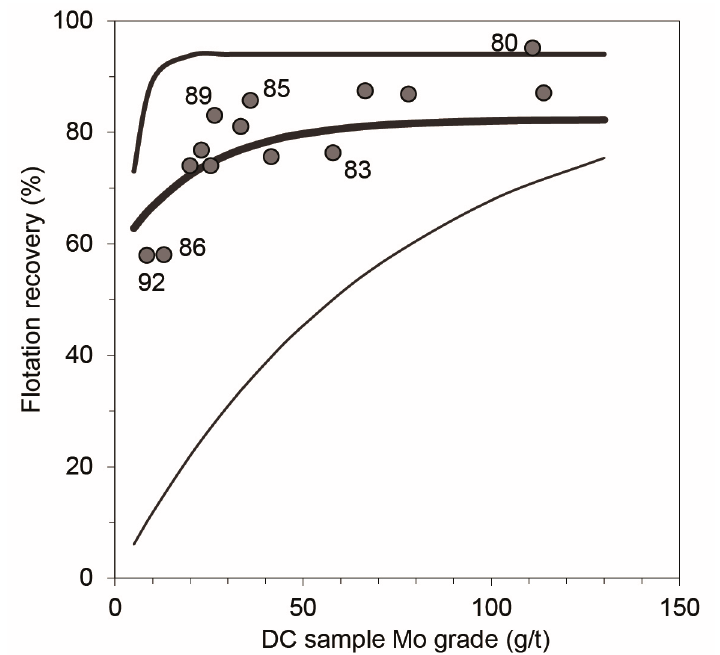
Figure 7. Molybdenum recoveries at 6% Cu rougher concentrate grade and Aitik normal (thick line), high (medium line) and low (thin line) production results. Laboratory data consists of mean values of the tests at 7 and 11 min of grinding. Plant data represents daily Mo recovery to copper concentrate from nearly 2.5 years of production (11 May 2006 to 15 October 2008). Numbers represent the two last digits in the sample numbers presented in Table 2